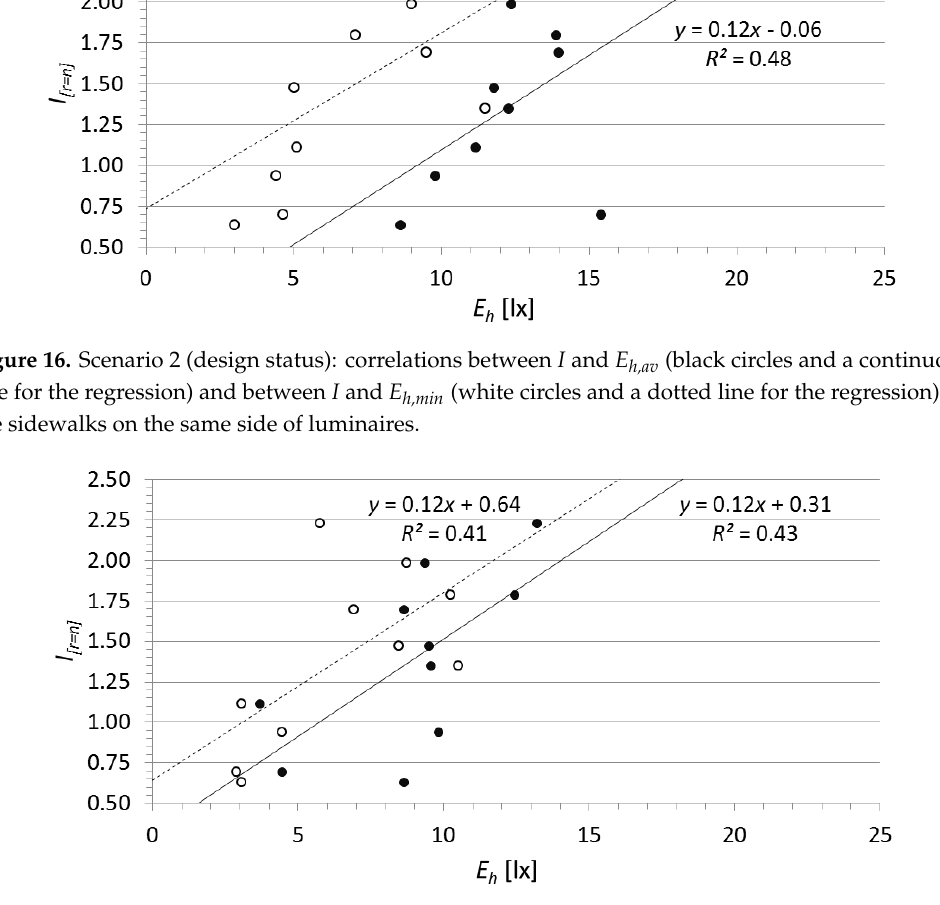
Figure 17. Scenario 2 (design status): correlations between I and E h,av (black circles and a continuous line for the regression) and between I and E h,min (white circles and a dotted line for the regression) on the sidewalks on the opposite side of the